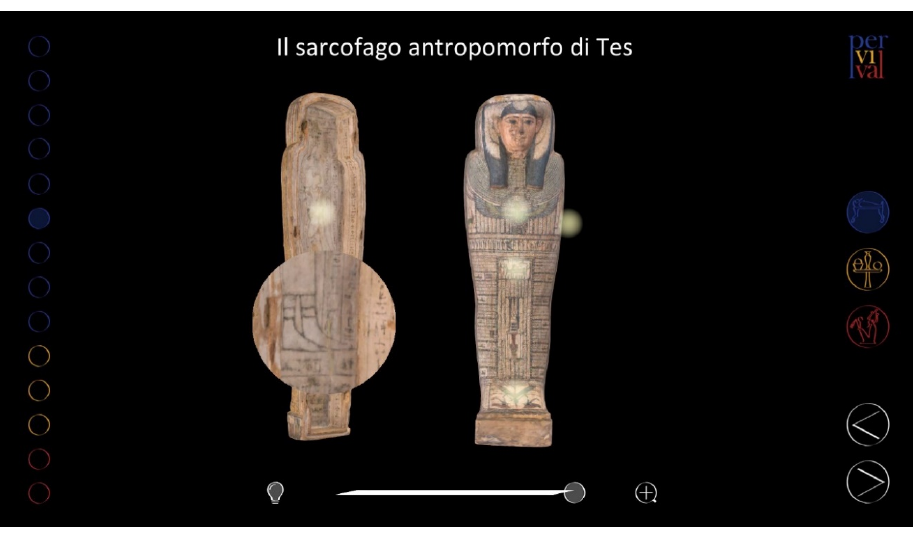
Figure 8. Digital app interface, navigation Level III page: single item automatic rotation and access to the interactive elements: hotspot selector, slider to replay the rotation, magnifying glass.